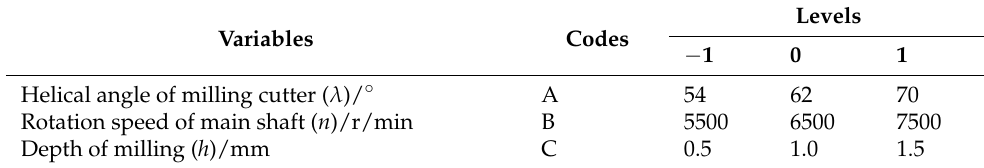
Table 2. Input variables and their levels.